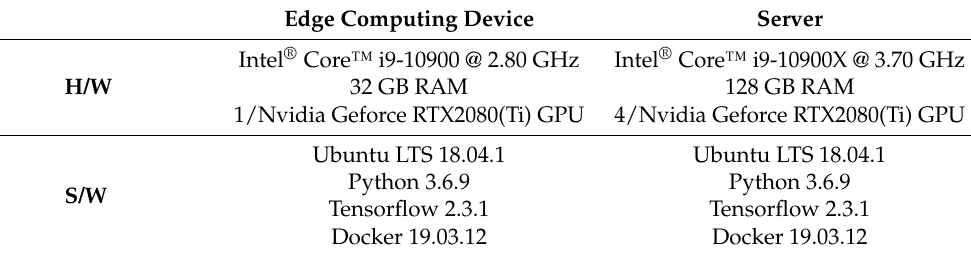
Table 1. Hardware and Software